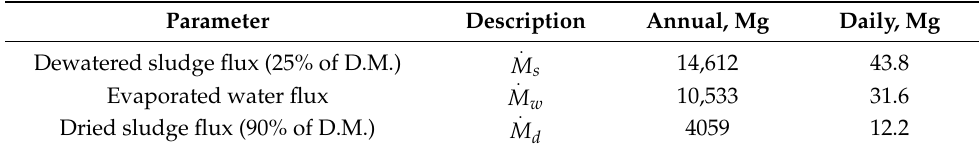
Table 1. Mass balance data of the analyzed drying plant.